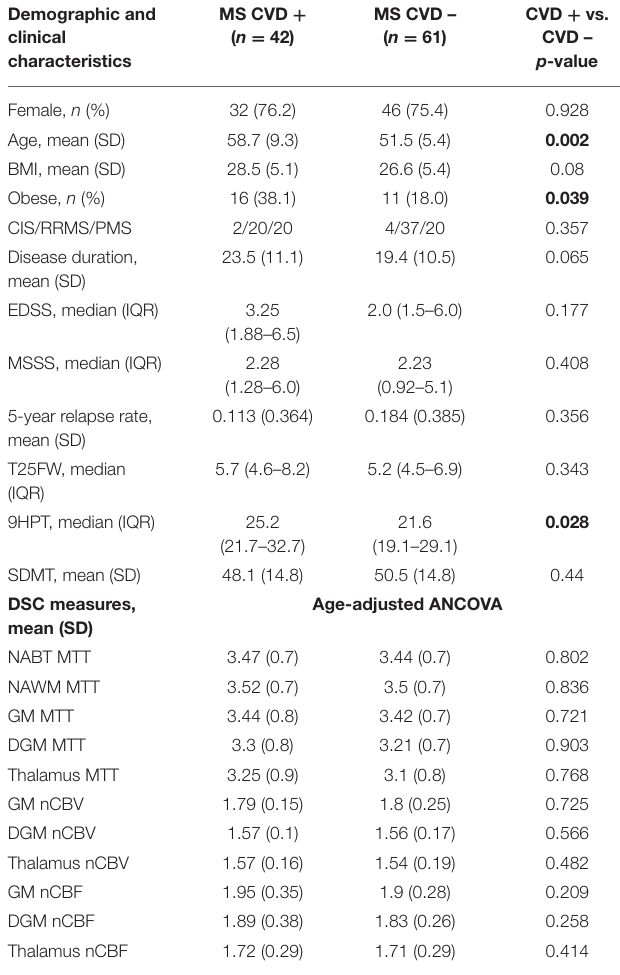
TABLE 3 | Differences in MTT between MS patients with and without at least one